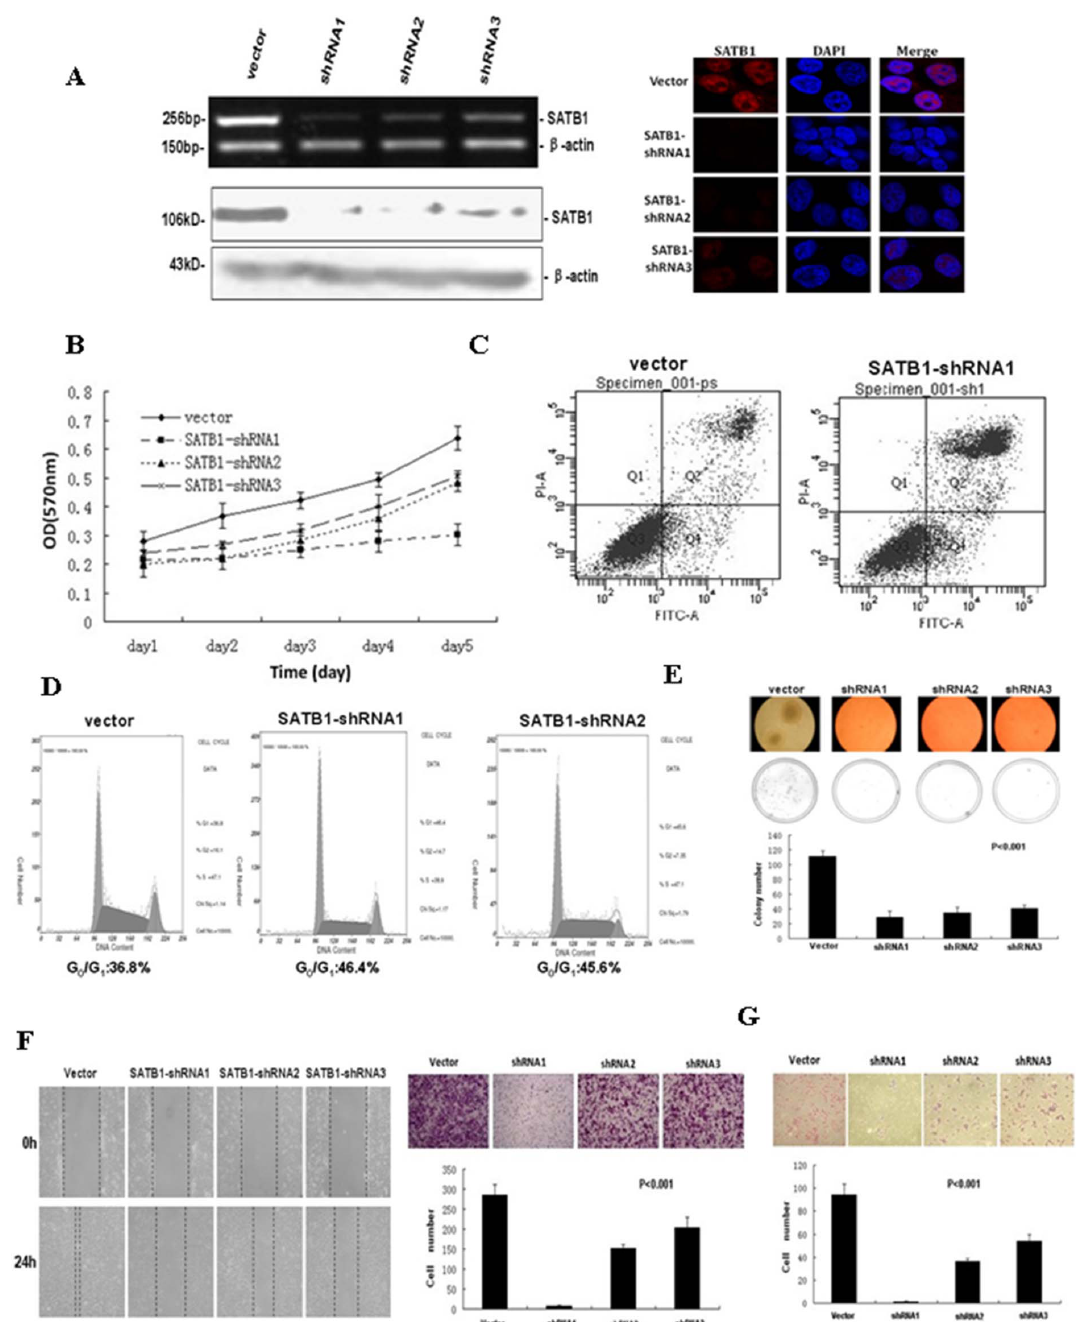
Figure 2. In LoVo cell lines, knockdown of SATB1 expression reduces cell proliferation, colony formation, migration, and invasion in vitro. (A) Three stable SATB1-knockdown LoVo cell lines were established using shRNA. Cells transfected with empty vector served as controls. The efficacy of SATB1 knockdown was verified by RT-PCR (top left panel), western blot (bottom left panel), and immunofluorescence (right panel). b - actin was used to ensure equal loading. (B) Cell proliferation of empty vector control, SATB1-shRNA1, SATB1-shRNA2, and SATB1-shRNA3 cells was determined by MTT assay. (C) Apoptosis of SATB1-shRNA1 and empty vector control cells was determined by flow cytometry analysis of PI and Annexin V staining. (D) Flow cytometry analysis of cell cycle in empty vector control, SATB1-shRNA1, and SATB1-shRNA2 cells. (E) Soft agar colony formation of empty vector control, SATB1-shRNA1, SATB1-shRNA2, and SATB1-shRNA3 cells after 3 weeks. *p , 0.001. (F) Migration of empty vector control, SATB1-shRNA1, SATB1-shRNA2, and SATB1-shRNA3 cells was determined by wound healing assay (left panel) and transwell migration assay (top right panel). The number of migrated cells in the transwell migration assay was quantified by counting the cells on the underside of the filter membrane in 5 randomly selected microscopic fields (lower right panel). *p , 0.001, number of migrated cells compared to control. (G) Cell invasion of empty vector control, SATB1-shRNA1, SATB1-shRNA2, and SATB1-shRNA3 cells was determined by Matrigel transwell invasion assay. The number of invaded cells was quantified by counting cells on the underside of the filter membrane in 5 randomly selected microscopic fields. *p , 0.001, number of invaded cells compared to control.